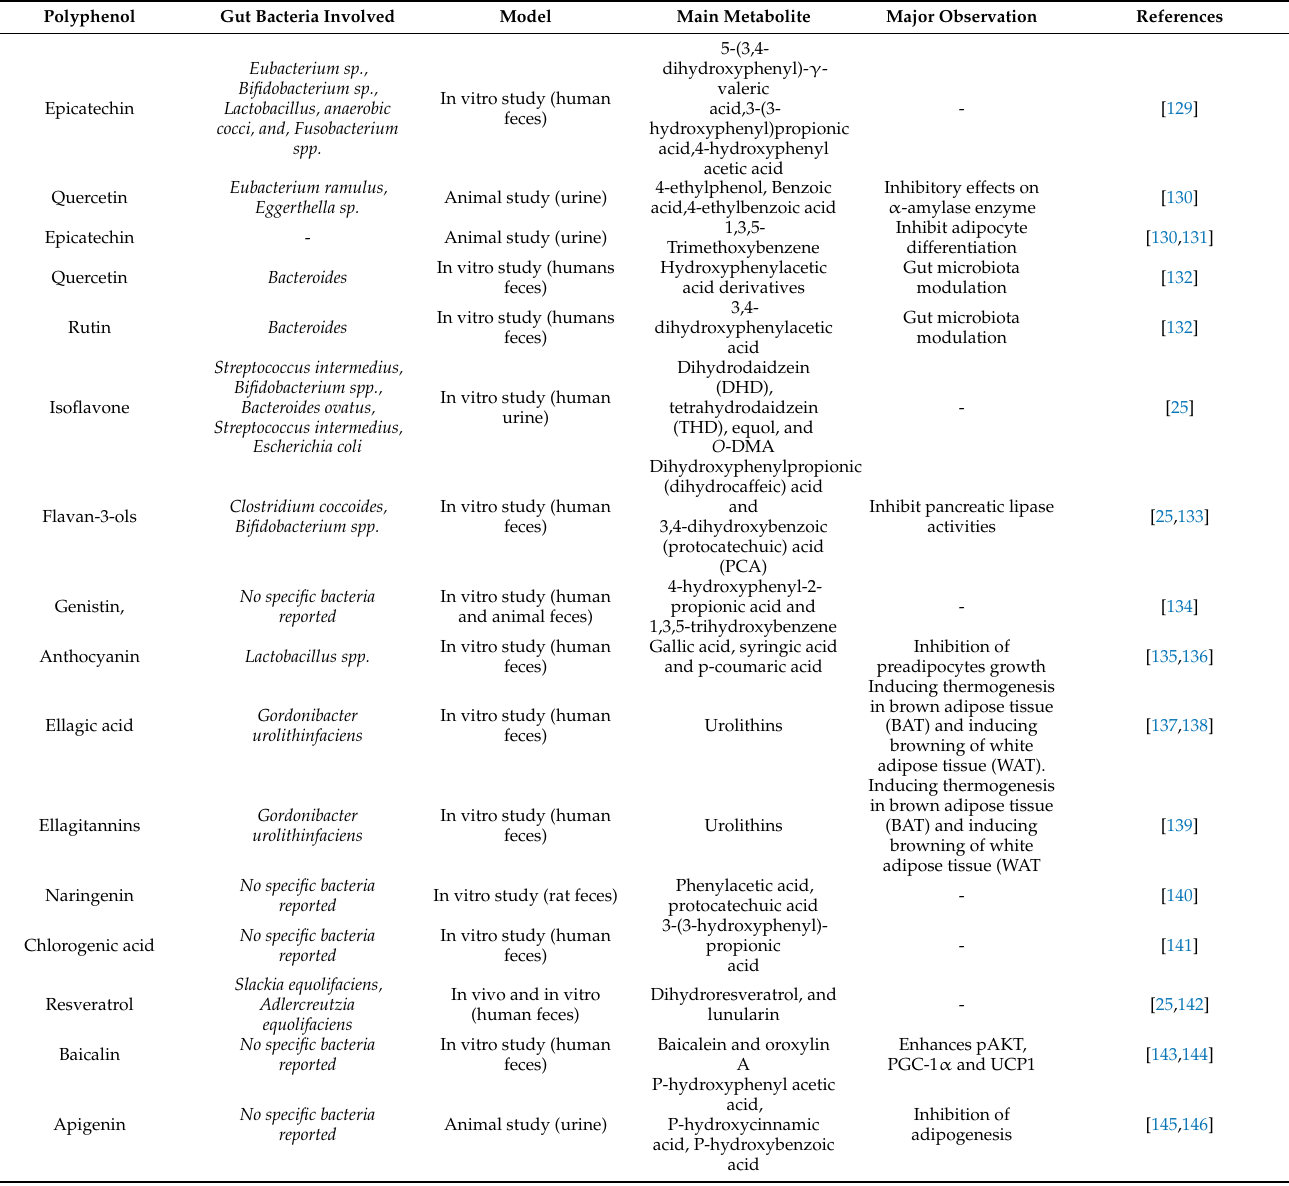
Table 6. Metabolites from the digestion of polyphenols by intestinal microbiota and their reported anti-obesity